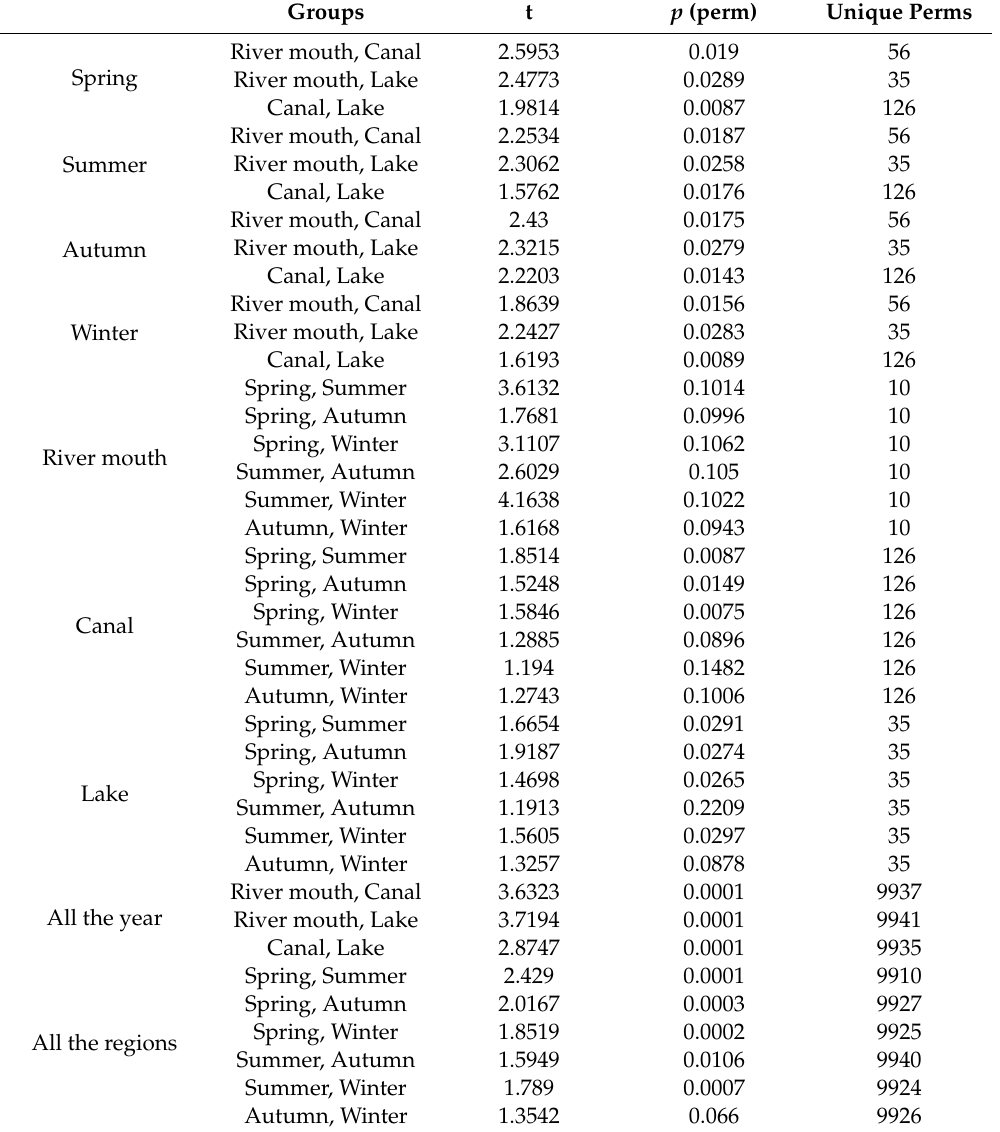
Table A3. Pair-wise tests of PERMANOVA analysis of macroinvertebrate communities. Groups t p (perm) Unique